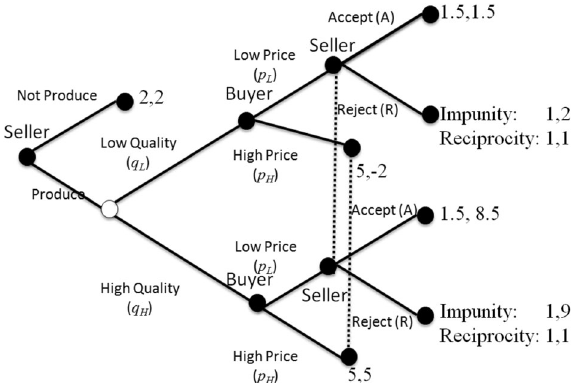
Fig. 2 Extensive form representation of the game in the laboratory